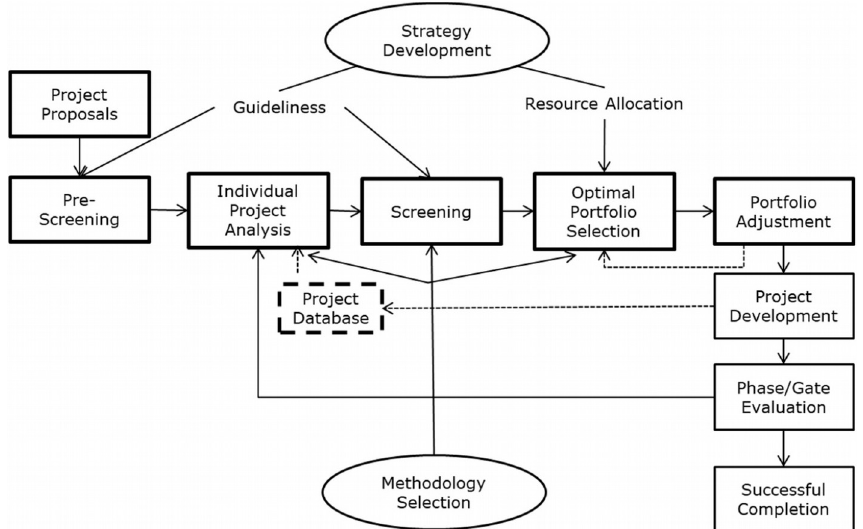
Figure 1. Framework for Project Portfolio Management (Archer & Ghasemzadeh,